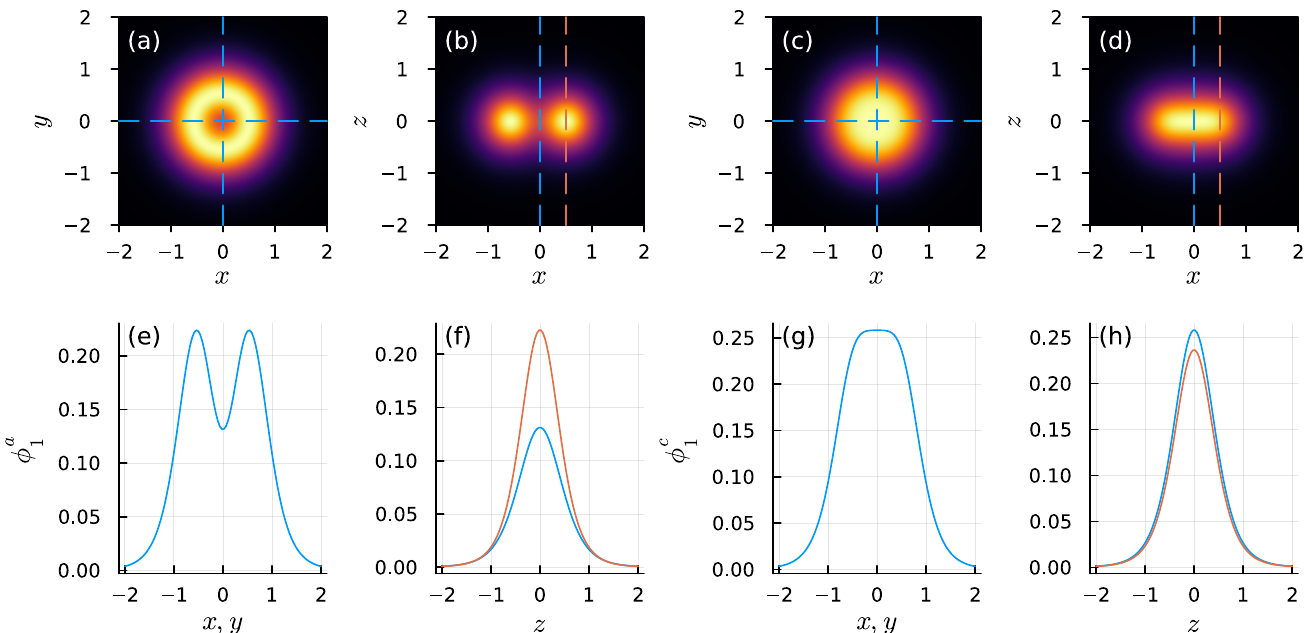
Figure 5. Force density profiles of the surface-oriented regularized Stokeslets, derived from (31), with (cid:101) = 1. The orientation is along the z -axis. ( a , b ) plot the cross section of φ a planes, respectively, and ( c , d ) similarly plot φ c shown in ( e ), as well as parallel to the z - axis for ρ = 0 and ρ = 1 in ( f ). Similar plots of φ c in ( g , h ). Values sampled along particular lines in ( e – h ) are indicated by dashed lines in ( a – d ), where there is a correspondence between columns of figures. For example, the blue and orange dashed lines in ( b ) respectively correspond to the blue and orange force density profiles in ( f